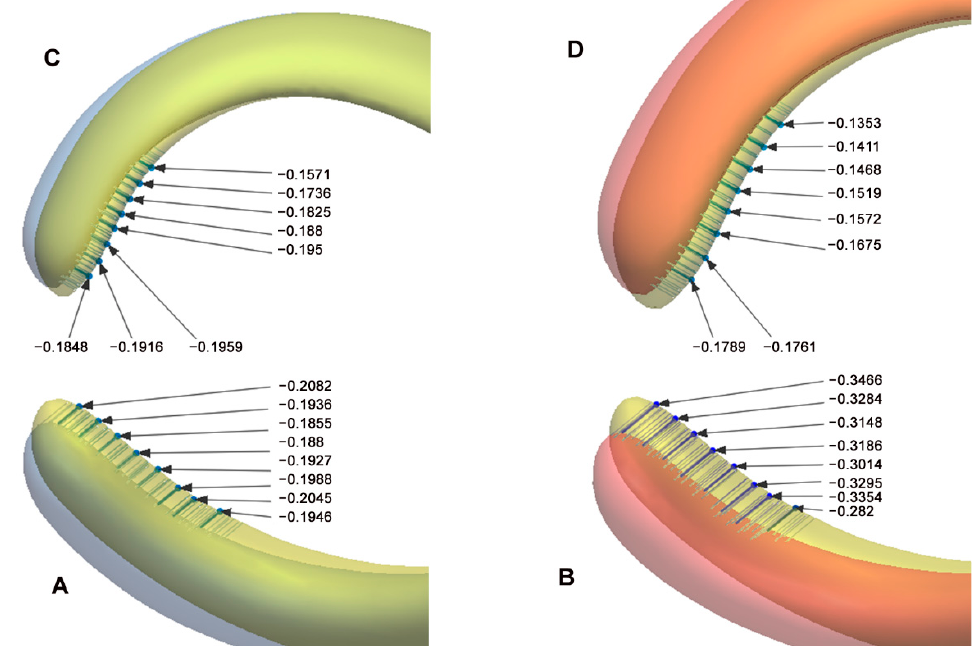
Figure 3. ( A , B ) Deviation analysis of the retentive arms of the PEEK and GBP materials, respectively. ( C , D ) deviation analysis of the reciprocal arms in the same sequence.